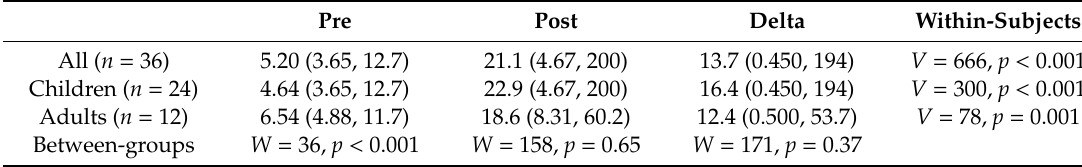
Table 2. Values of cardiac troponin T (cTnT) (ng / L).